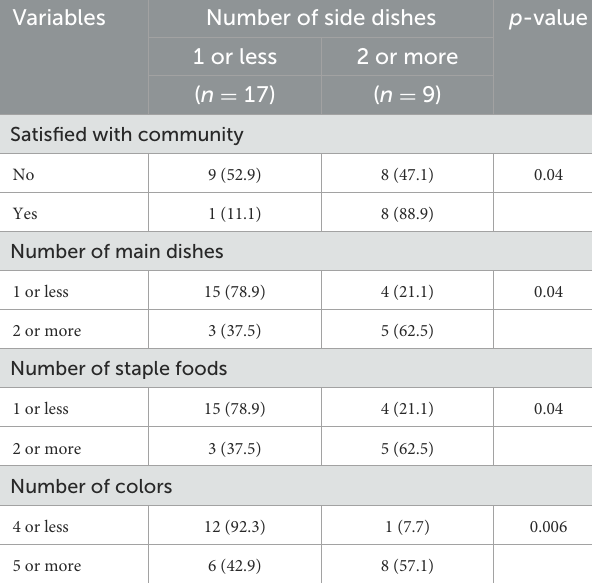
TABLE 3 Statistically significant associations between the number of side dishes that children draw and satisfaction with their community of residence and the number of other items that comprise their